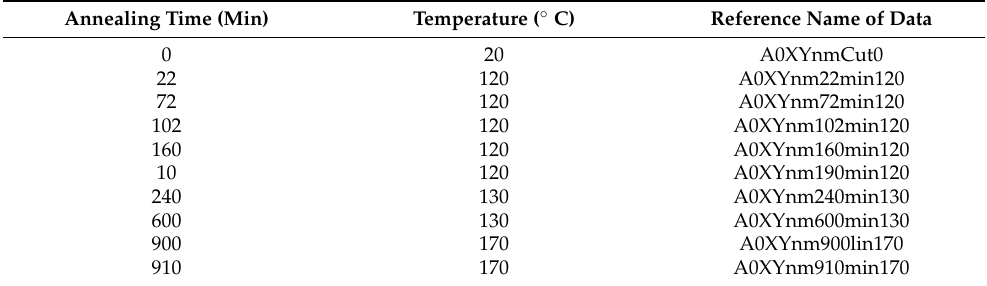
Table A1. Sample preparation. Three samples of copper initial target thicknesses XY = 10, 30 and 50 nm were successively